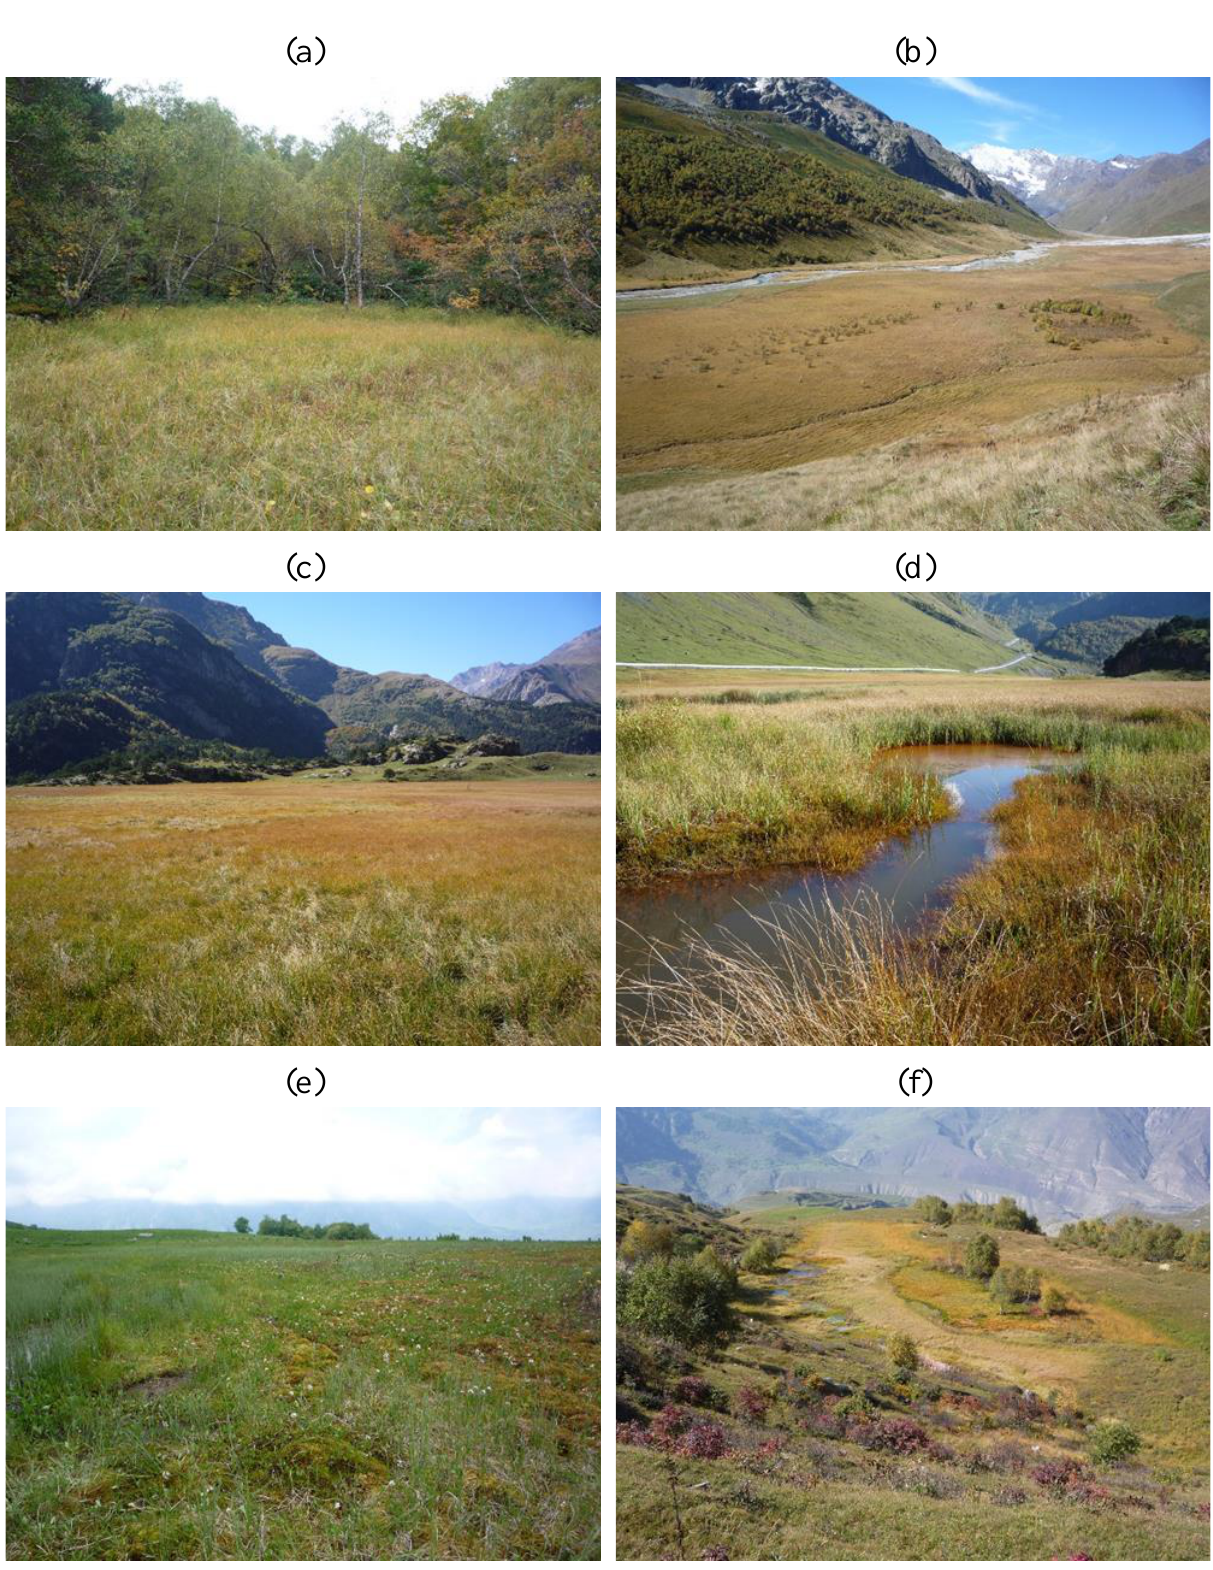
Figure 1. Mires of the North Caucasus: (a) Kubus; (b) Chifandzar; (c) and (d) Ushtulu; (e) Konskoe; (f) Zayachye. Photos: D.A.